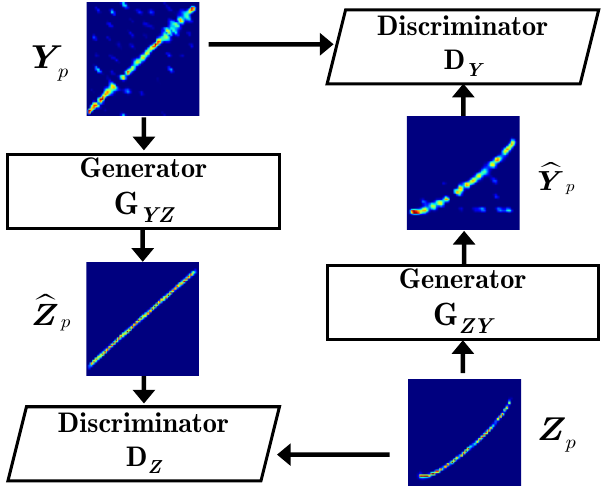
Figure 4. Processing framework of CycleGAN.